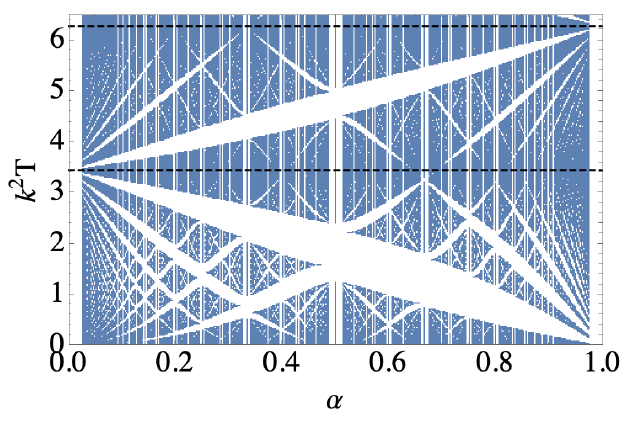
n T = 2. We consider all rational 0 0